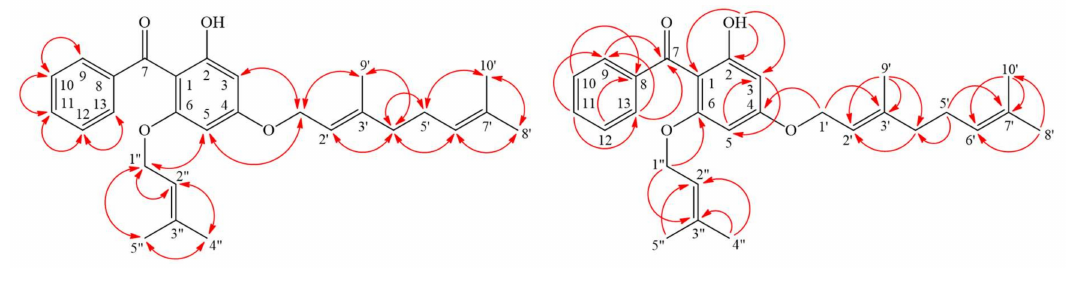
Figure 3. Key NOESY ( ) and HMBC ( ) correlations of 1 . NOESY—nuclear Overhauser e ff ect spectrometry; HMBC—heteronuclear multiple-bond